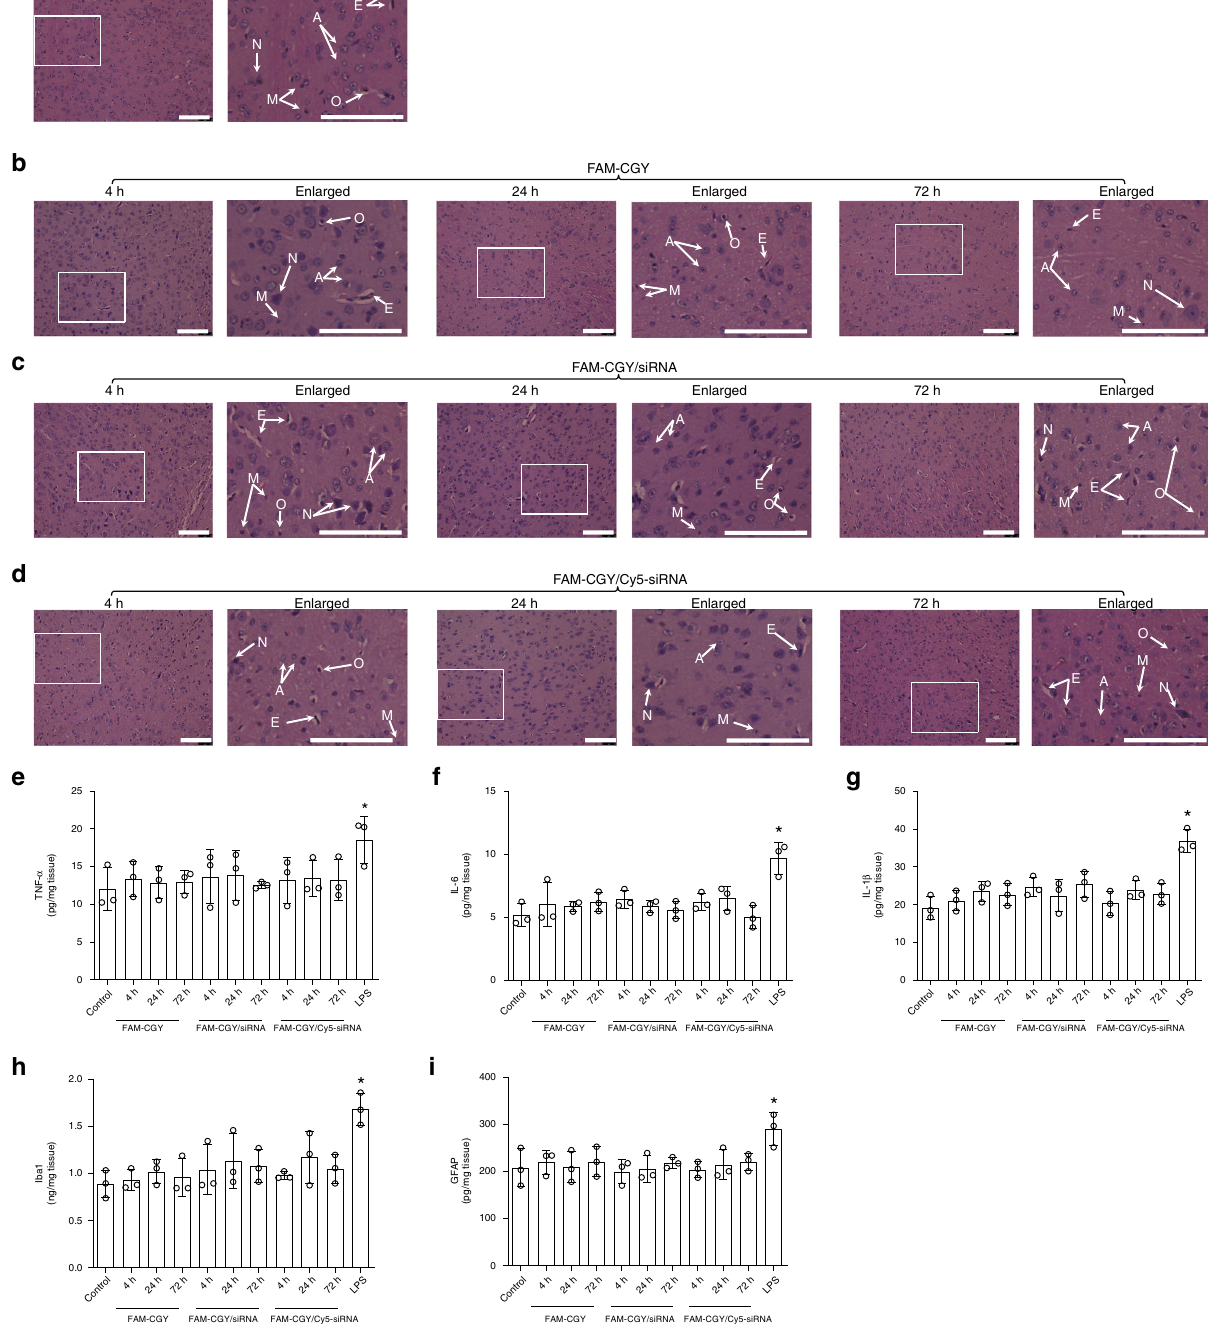
Fig. 6 Brain safety of intravenously injected NLCs and NLC-siRNA complexes. The images show haematoxylin and eosin stained sections of cerebral cortex at 4 h, 24 h and 72 h after administration of saline ( a ), FAM-CGY peptide (10 μ M) ( b ), FAM-CGY/BACE1-speci fi c siRNA ( c ) and FAM-CGY/Cy5-siRNA complexes ( d ). In ( c ) and ( d ) FAM-CGY and siRNA concentrations were 10 μ M and 48 nM, respectively. Magni fi ed regions of box inserts are shown. E = cerebral endothelial cells, G = glial cells, M = microglial cells and N = Neurons. Scale bar = 100 μ m. ELISA determination of pro-in fl ammatory markers TNF- α ( e ), IL-6 ( f ) and IL-1 β ( g ) in hippocampus on NLC and NLC-siRNA treatments compared with control ( p > 0.05 in all cases; n = 3 determinations). Determination of microglial marker Iba-1 ( h ) and astrocyte marker GFAP ( i ) in hippocampus on NLC treatment ( p > 0.05 in all cases; n = 3 determinations). Lipopolysaccharide (LPS) injection induced a small, but signi fi cant (* p < 0.05 in all cases compared with control and NLC treatments; n = 3 determinations) proin fl ammatory response at 24 h sacri fi ce point. All statistical analyses were performed with one-way ANOVA, using Tukey ’ s multiple comparison correction to calculate signi fi cance. Source data are available in the Source Data fi